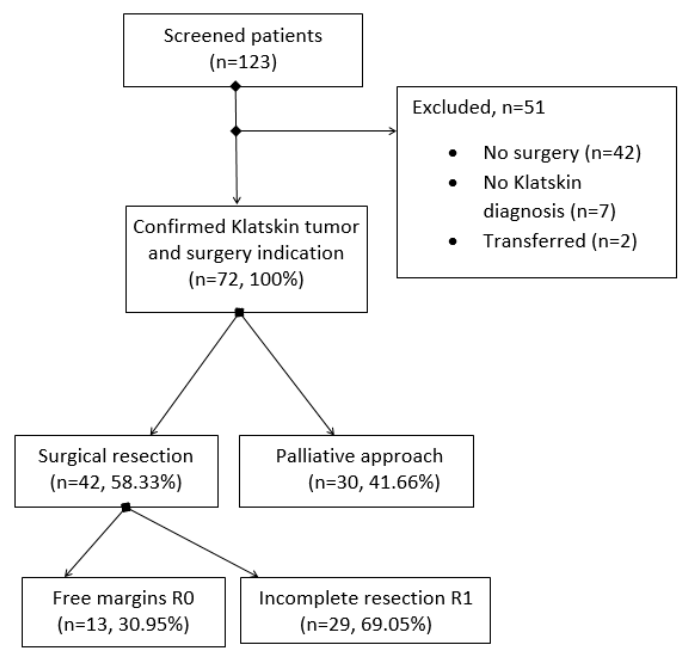
Figure 1. Flowchart with patients’ enrollment.